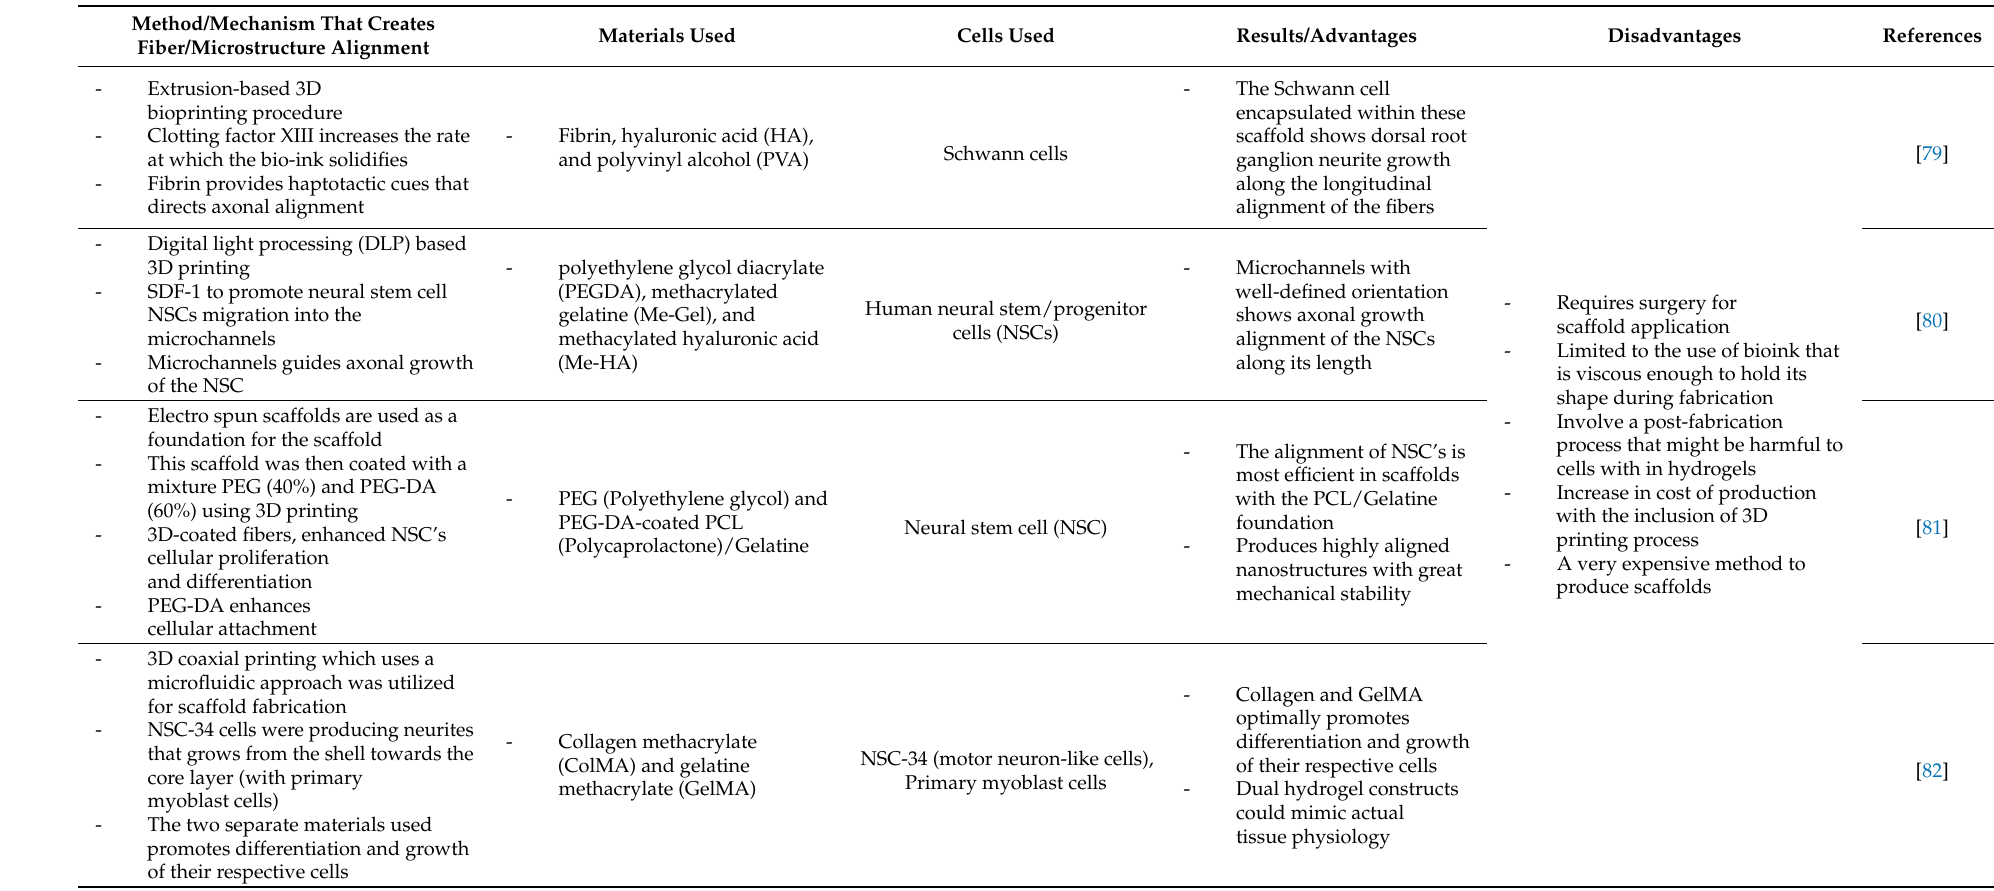
Table 3. Summary of bioprinting-based fabrication methods to produce scaffolds for